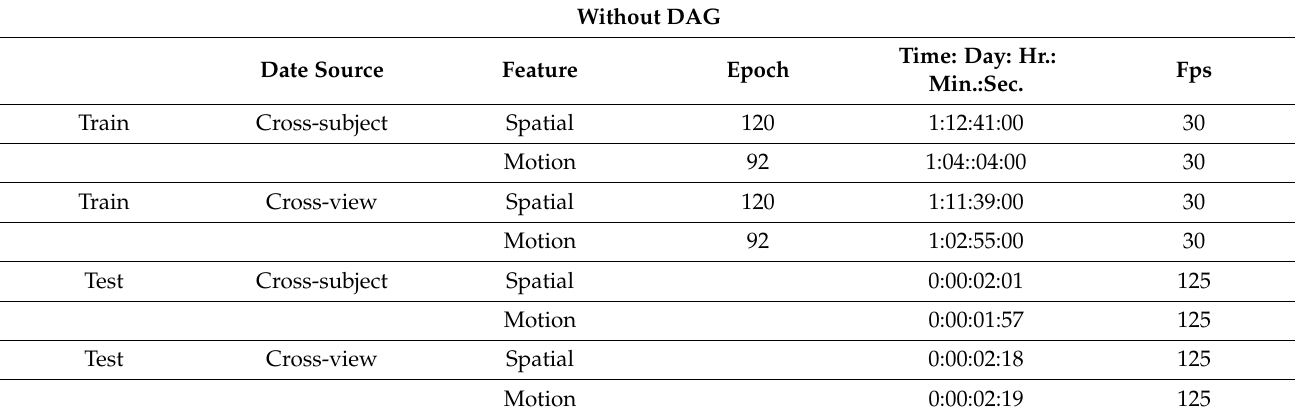
Table 8. The training and testing time with and without DAG